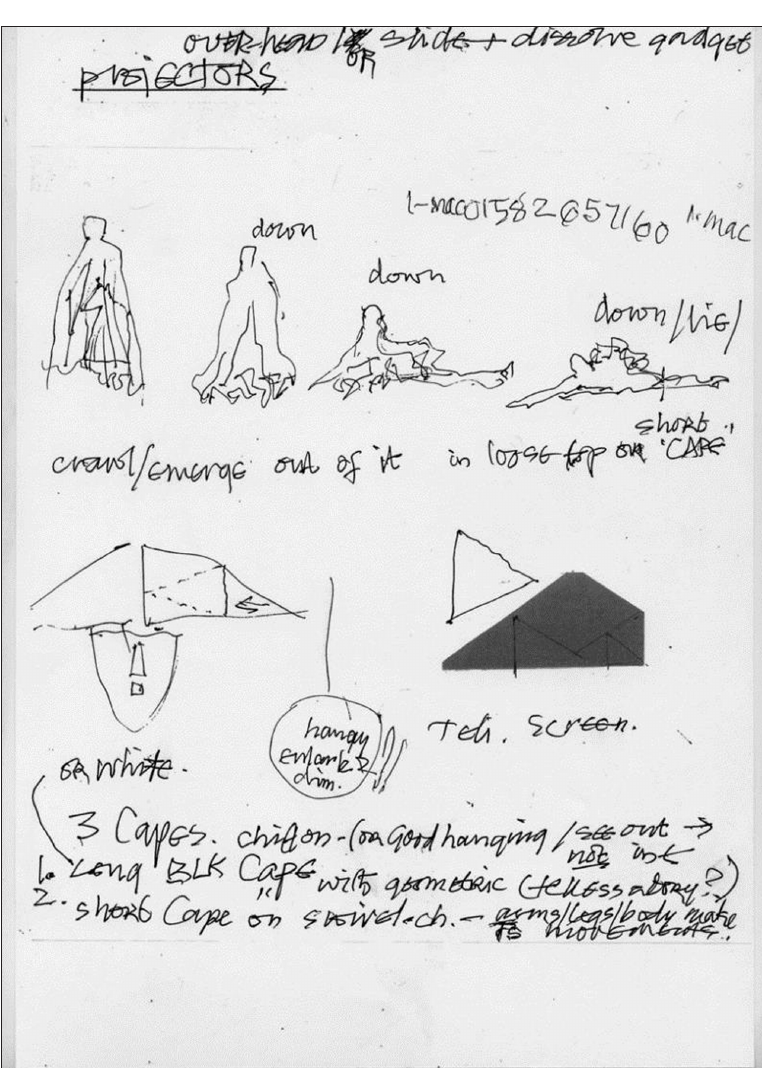
Figure 5: Jennifer Pike, notes for ‘Tessellations’. Courtesy of Veryan